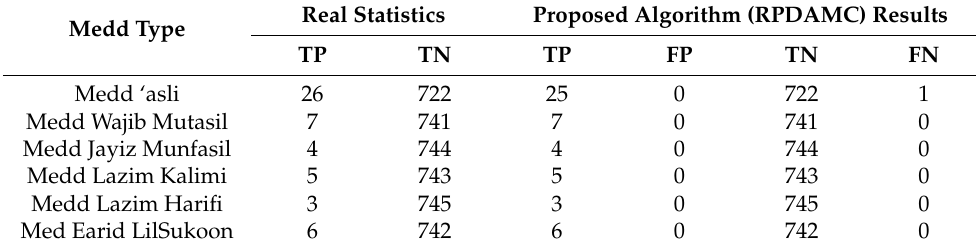
Table 4. Real and RPDAMC